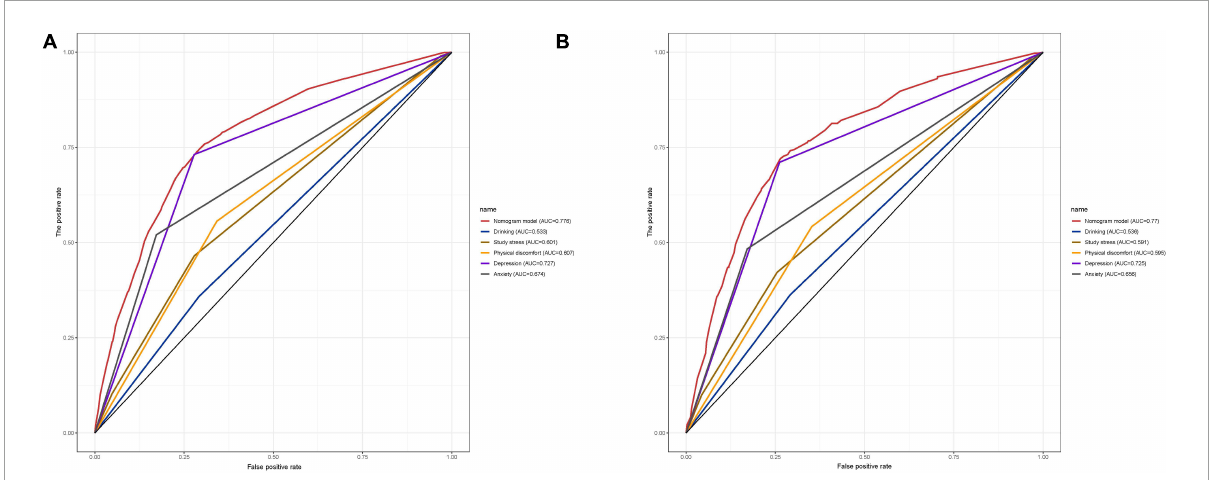
FIGURE4 The ROC curve of the developed nomogram for predicting poor sleep quality in medical students. AUC, the area under the curve. (A) ROC curve of the training set nomogram. (B) ROC curve of the validation set nomogram.